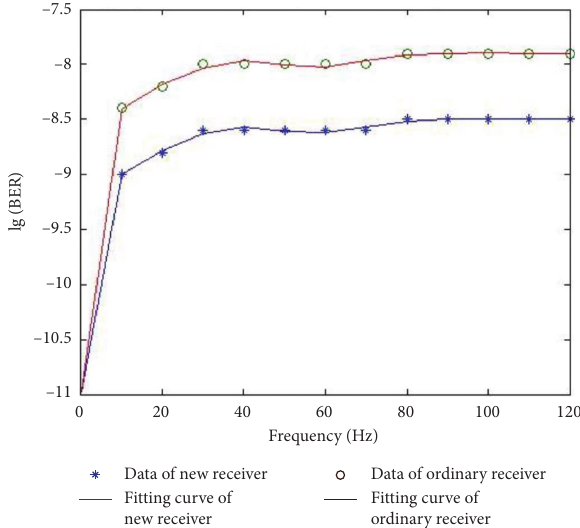
Figure 10: lg(BER) of both new and ordinary receivers (amplitude: 100